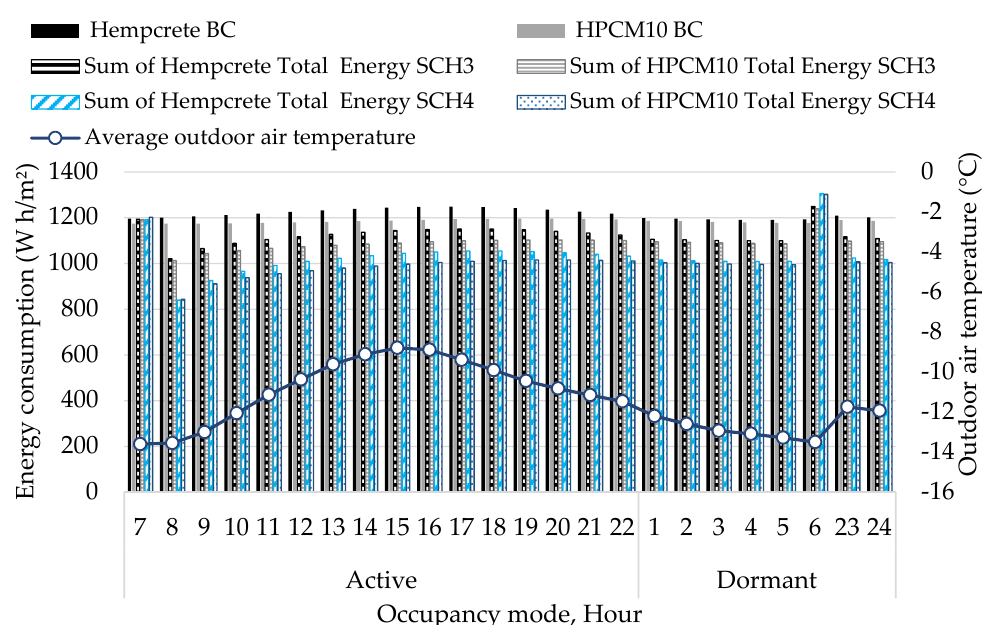
Figure 12. Average monthly heating and cooling energy consumption under BC, SCH3, and SCH4.